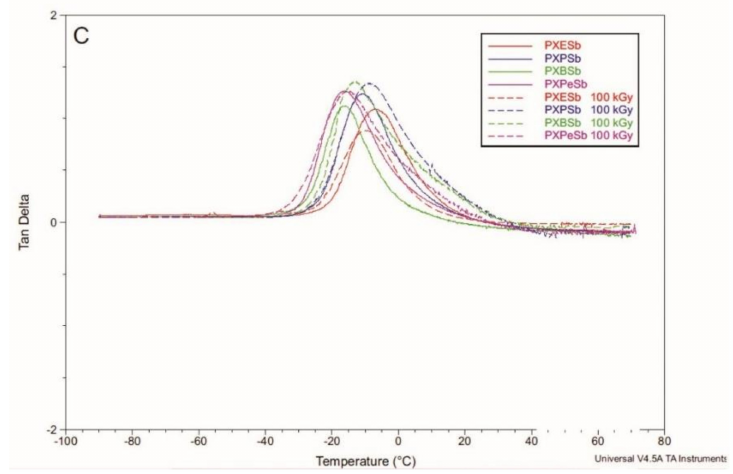
Figure 10. ( A ) E (cid:48) (storage modulus), ( B ) E (cid:48)(cid:48) (loss modulus), and ( C ) loss tangent tested by DMTA for PXESb, PXPSb, PXBSb, and PXPeSb.